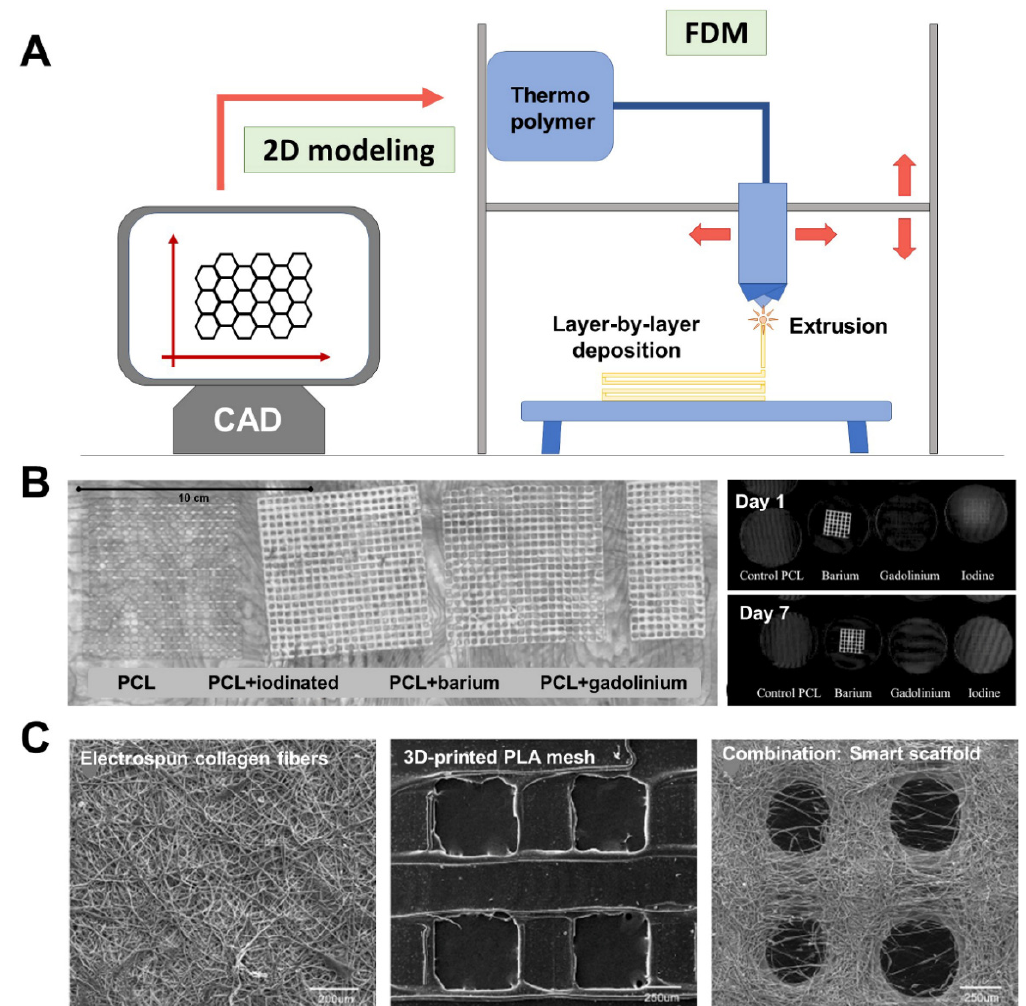
Figure 2. Illustrative examples of different devices for hernia repair fabricated by 3D-printing. ( A ) Schematic diagram of FDM additive-manufacturing technology. ( B ) Left panel: maximum-intensity coronal reconstruction of printed PCL meshes endowed with contrast agents (iodine-based, barium, gadolinium) for computed tomography (CT) traceability. Right panel: CT pictures showing coronal volume of the meshes after 1 and 7 days of culture on agar plates at 37 °C. Original pictures from [83] adapted with permission from BMC-Springer Nature (Creative Commons Attribution 4.0 International License). ( C ) Scanning electron microscopy (SEM) images of a smart scaffold elaborated by interleaving of a 3D-printed PLA mesh with electrospun type-I collagen fibers. Original pictures from [84] adapted with permission from BMC-Springer